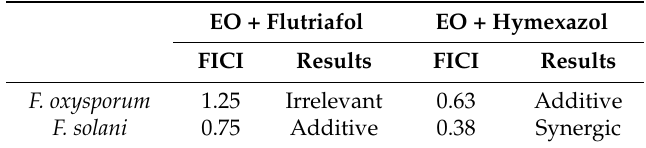
Table 3. The FICI values by combining A. annua EO with chemical fungicides. EO + Flutriafol